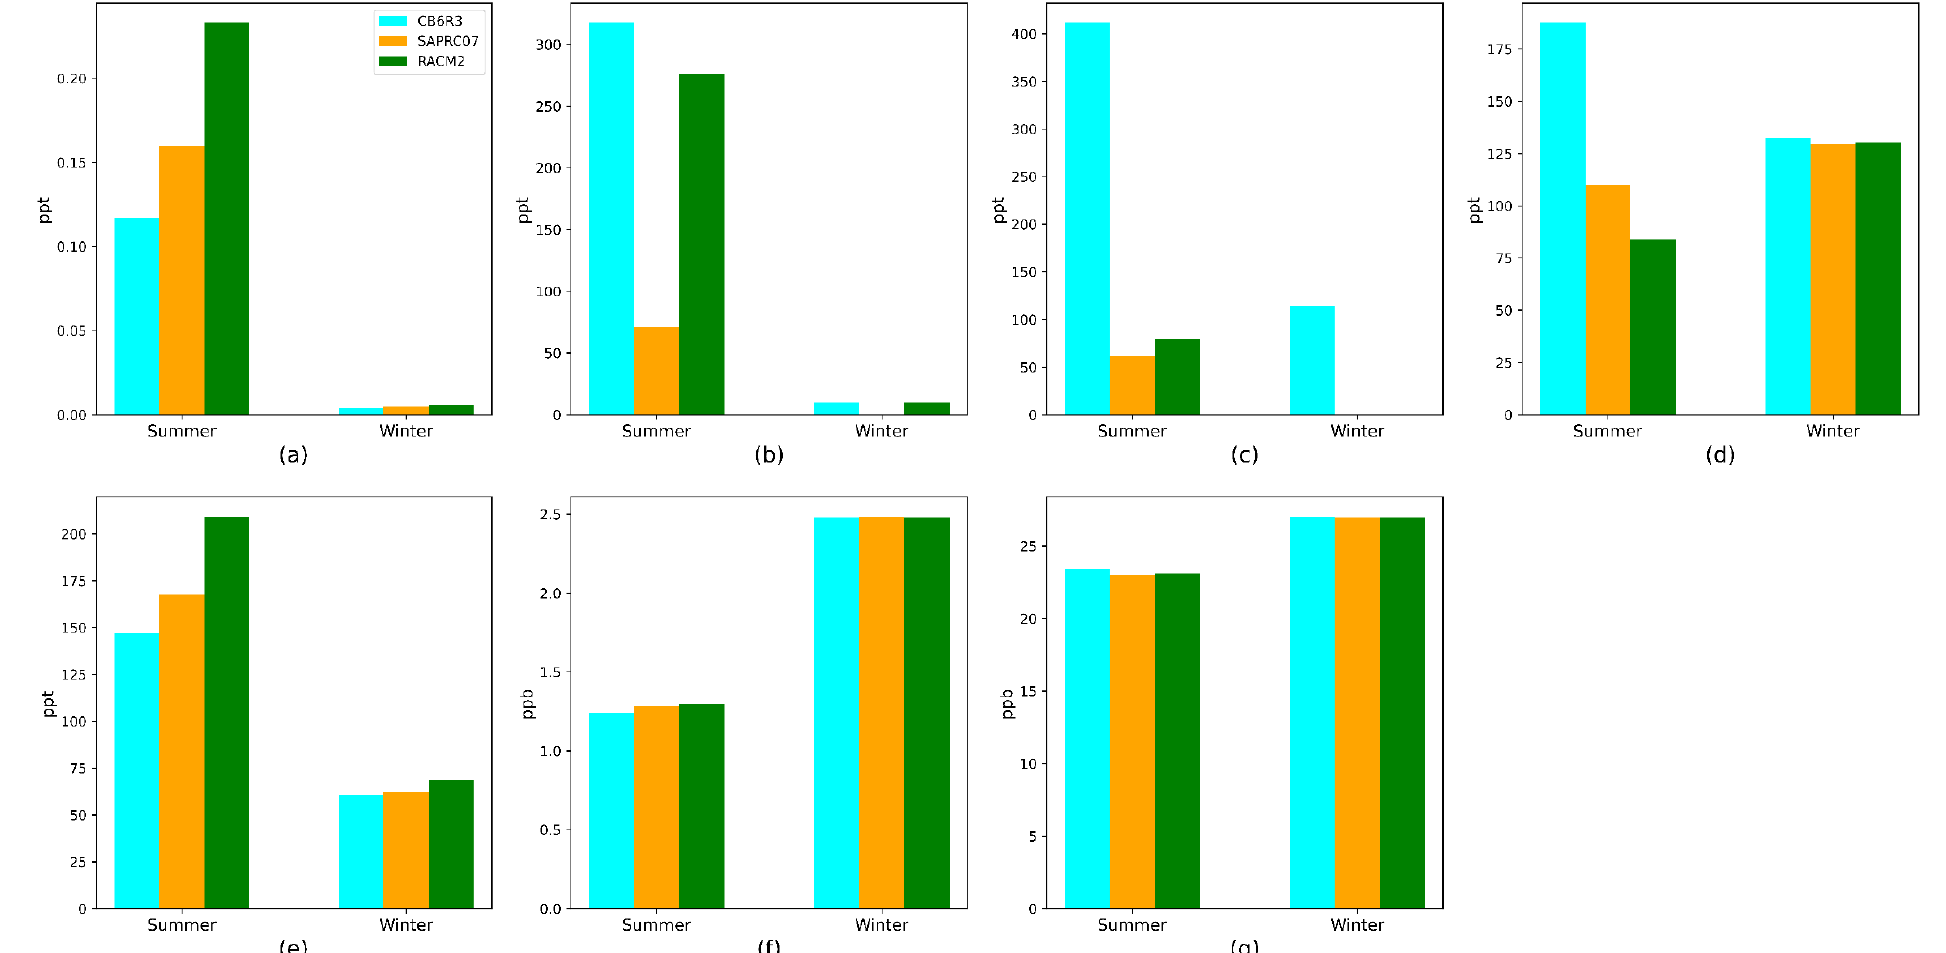
Figure 3. Comparison of CB6R3, SAPRC07, and RACM2 predicted monthly mean values for ( a ) OH, ( b ) H 2 O 2 (SAPRC07 value in Dec is very small when compared to CB6R3 and RACM2) ( c ) MEPX (SAPRC07 and RACM2 values in Dec are very small when compared to CB6R3), ( d ) PAN, ( e ) TNO 3 , ( f ) NO X , ( g ) O 3 .